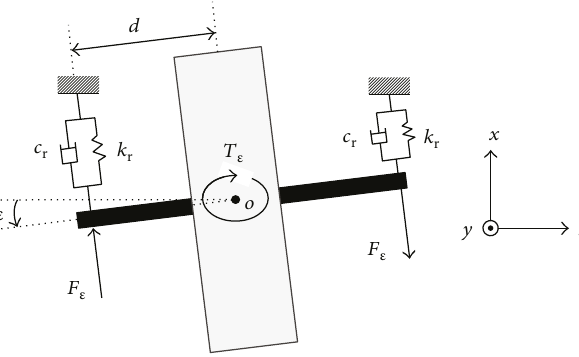
Figure 6: Equivalent model of y -axis torsional springs.